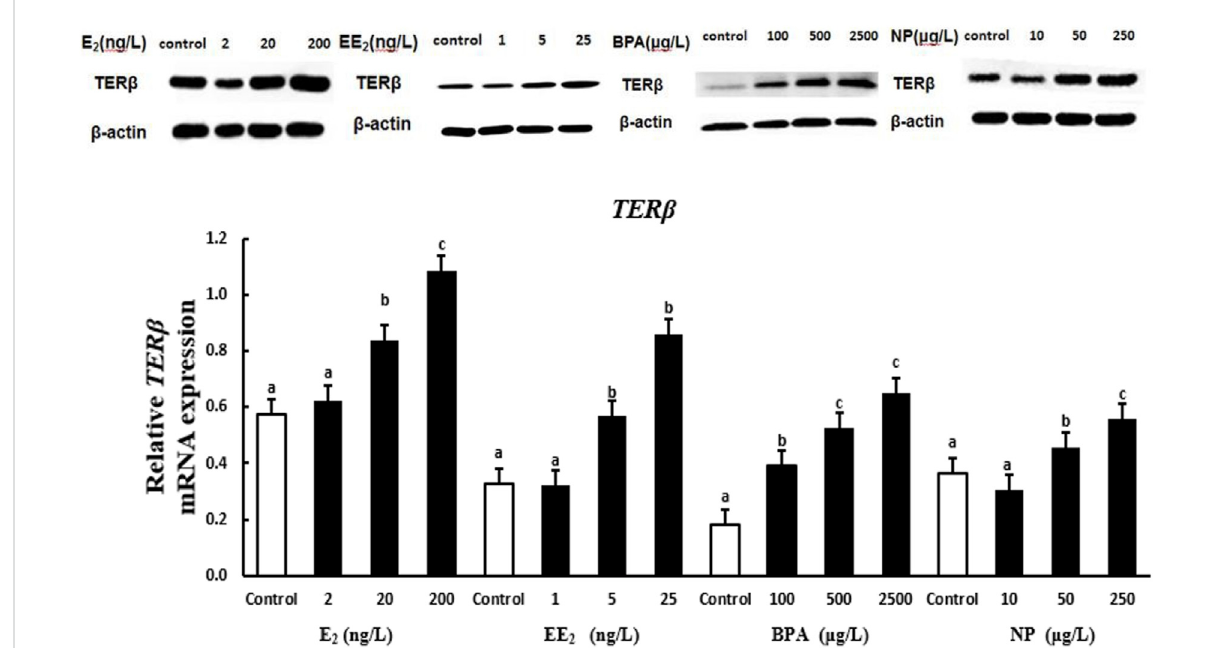
FIGURE 6 Effects of EDCs on the level of the protein encoded by ter β in the testis tissue of T. albonu bes. Columns with different letters are signi fi cantly different at p < 0.05 according to one-way ANOVA followed by Dunnett ’ s